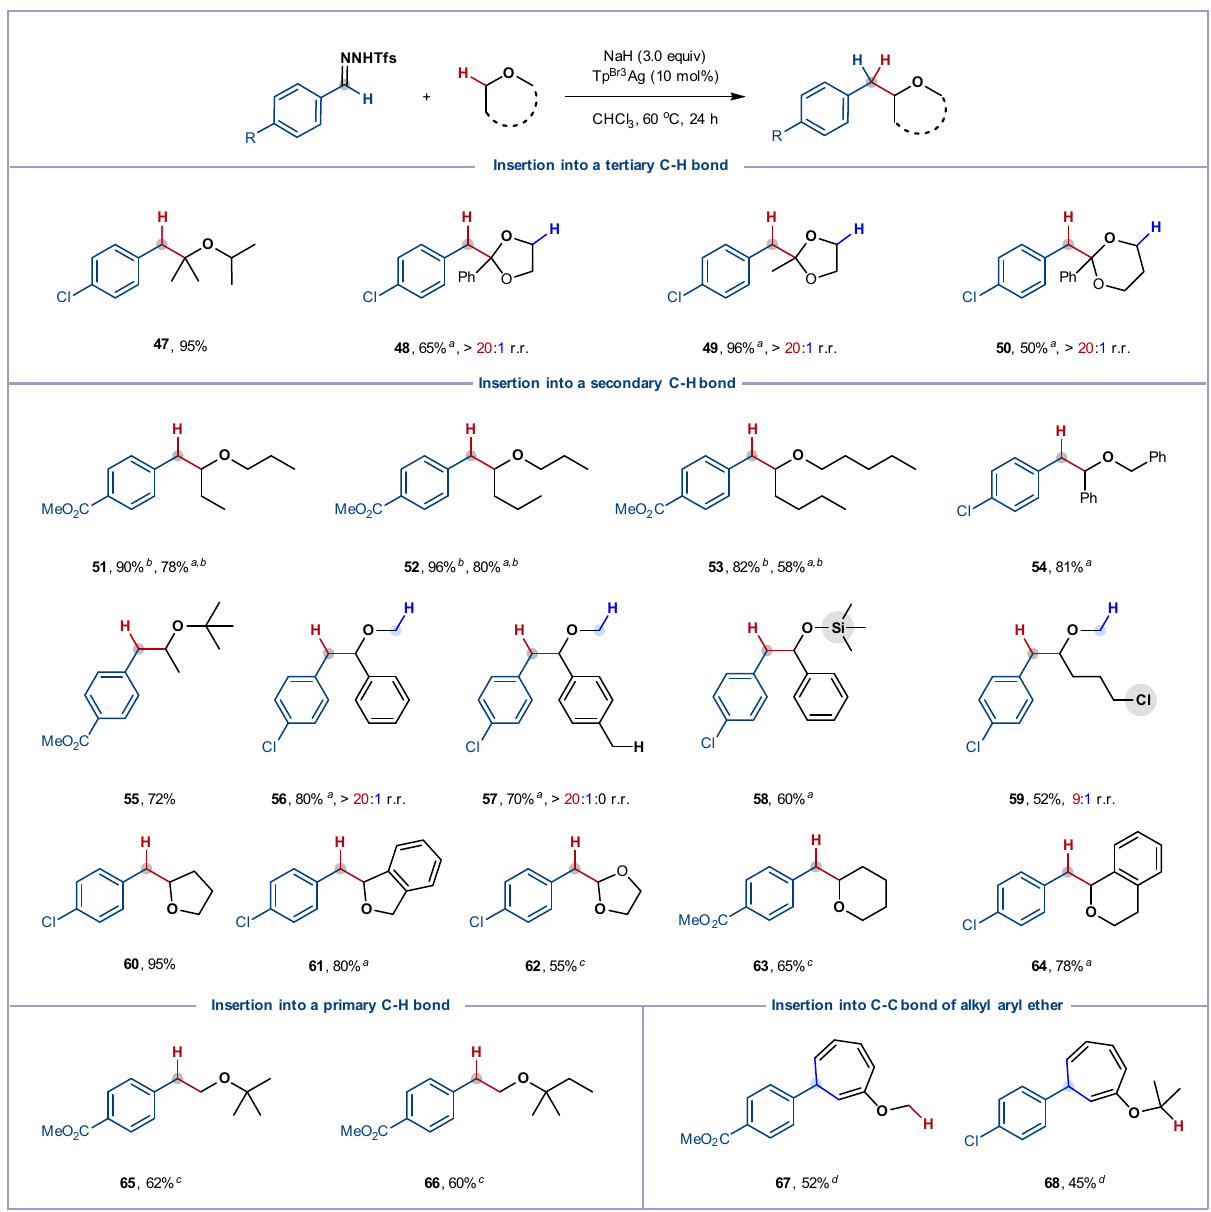
Fig. 4 Substrate scope with respective to ethers. Reaction conditions are the same as in Fig. 3. a Ether (2.0 equiv) was used. b PhCF 3 (5.0 mL) was used. c Ether (5.0 mL) was used. d Ether (5.0 equiv) was used. r.r., regioisomeric